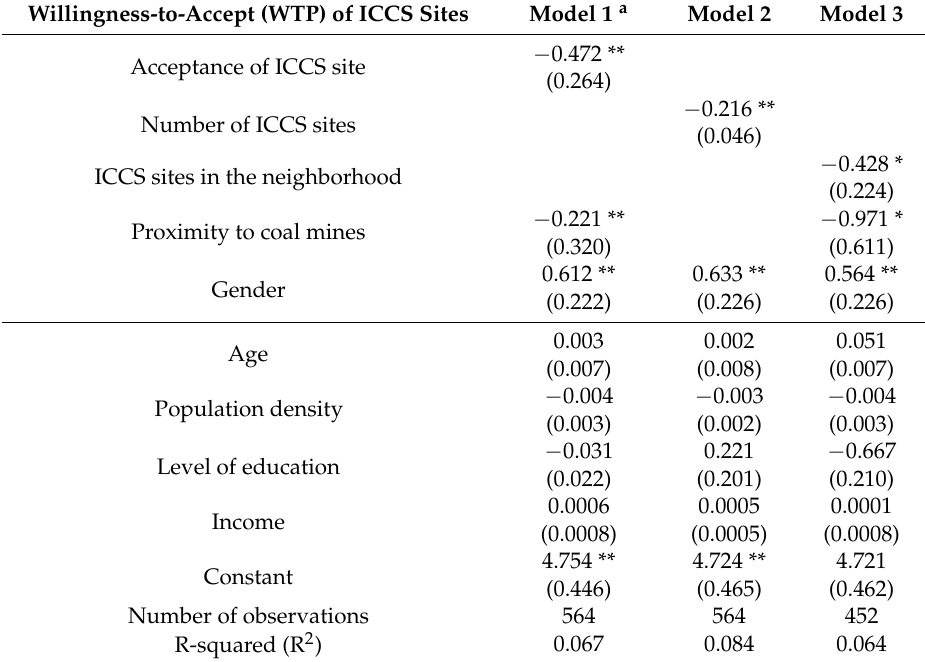
Table 2. Ordinary least squares (OLS) regression clustered standard